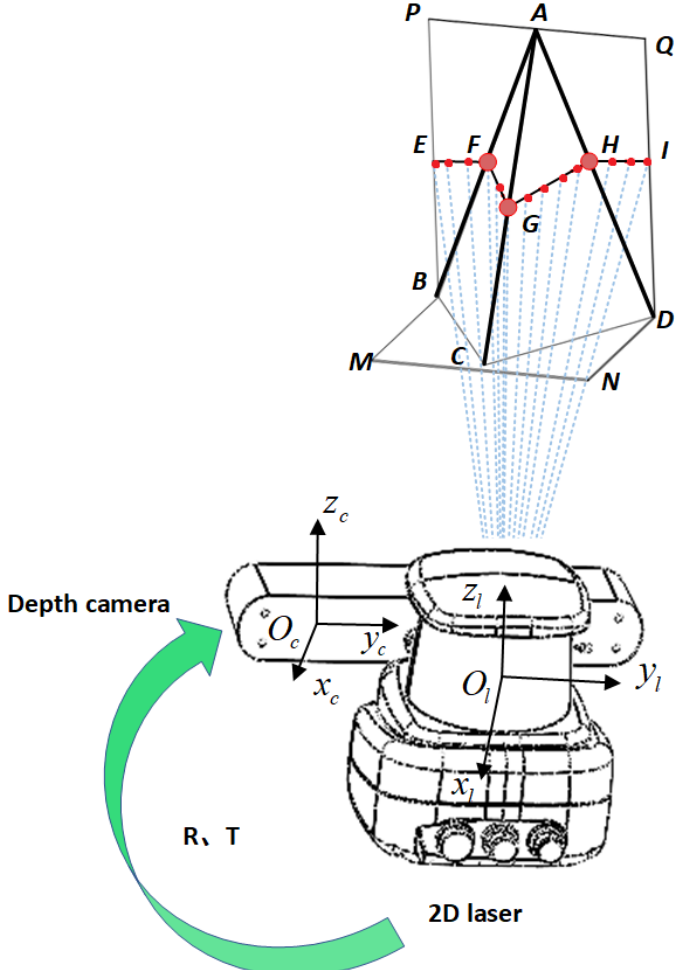
Figure 4. Feature point